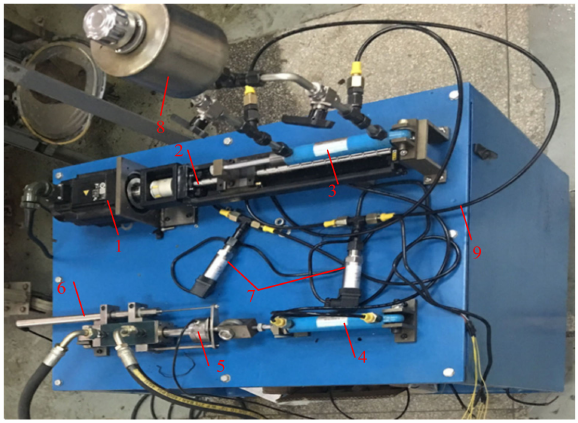
Figure 6. Experimental system.1. Stepping motor; 2. Ball screw; 3. Power cylinder; 4. Target cylinder;